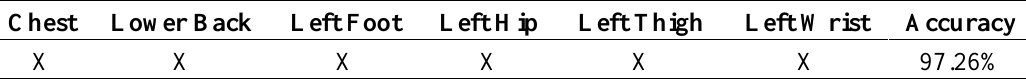
Table 10. Percentage correctly classified instances for 6 location